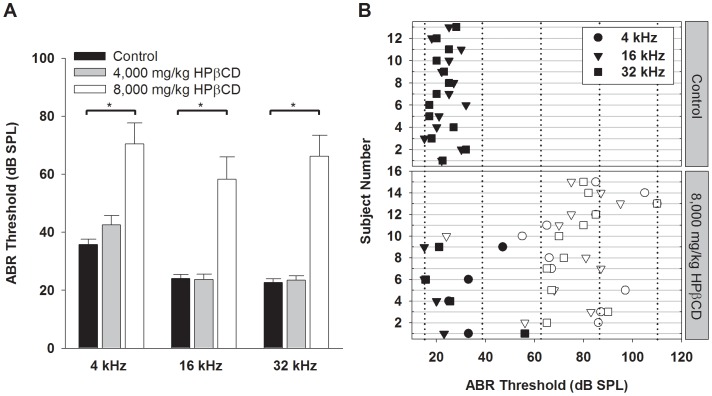
ABR thresholds are elevated one week following treatment with HPβCD.(A) Mean thresholds are shown for 4, 16, and 32 kHz. Control, N = 13; 4,000 mg/kg, N = 12; 8,000 mg/kg, N = 15. Error bars represent one standard error of the mean. * P<0.05. (B) Scattergram of thresholds shown by subject for control and 8,000 mg/kg treatment groups. Closed and open symbols in the drug treated group represent animals assigned to “unaffected” and “affected” categories, respectively.